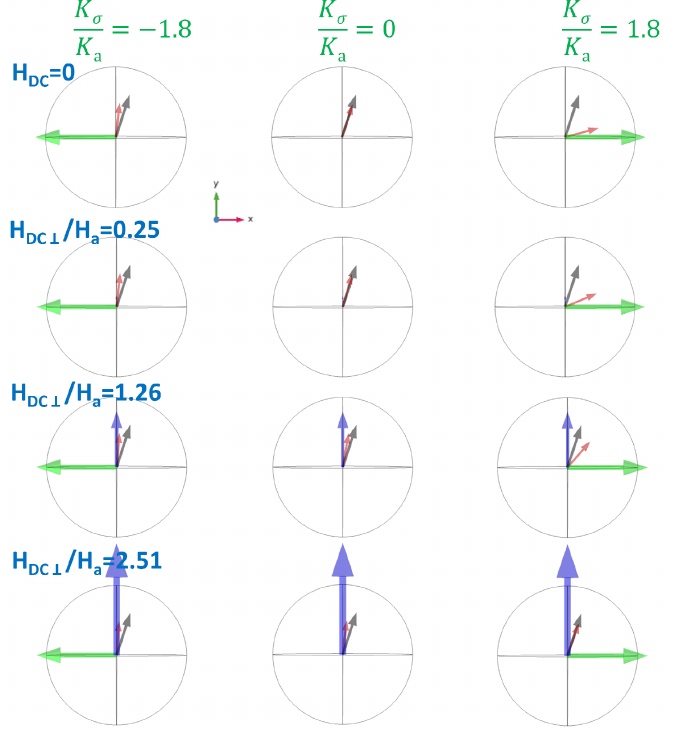
Figure A3. Snapshots of the magnetic state of the Magnetization (in red) at a given magnetic anisotropy (in black), for different stress (in green) and different perpendicular applied field (in blue).